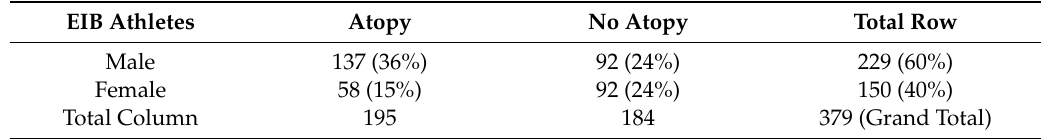
Table 6. Sex di ff erences in atopic status in athletes with diagnosis of EIB.